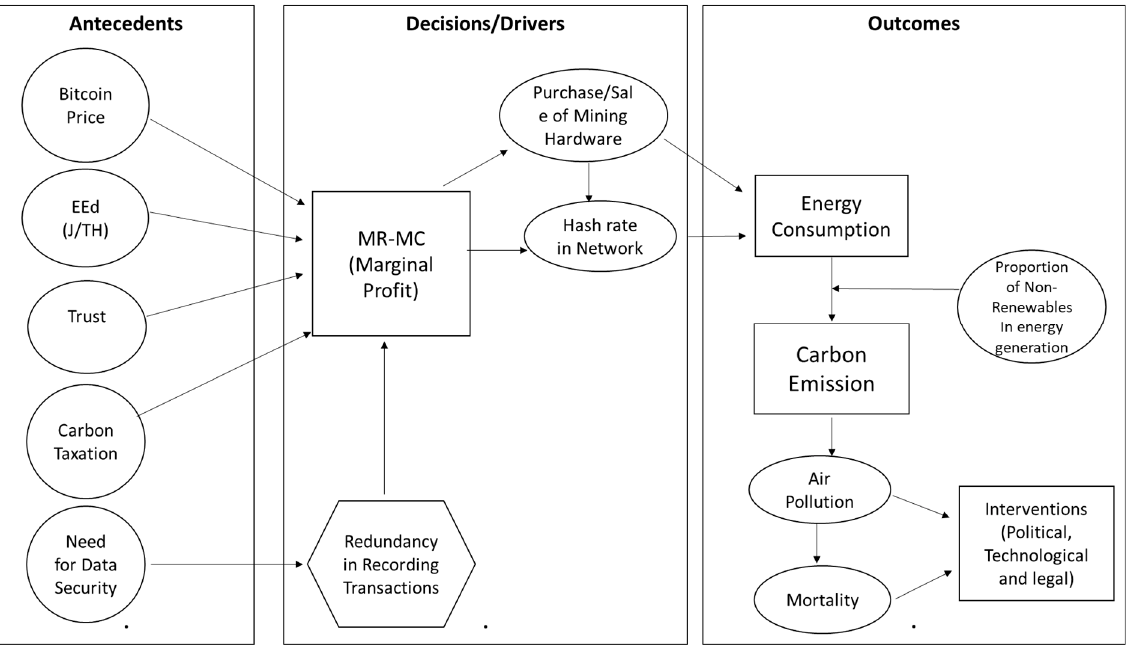
Figure 8. Proposed ADO Model.